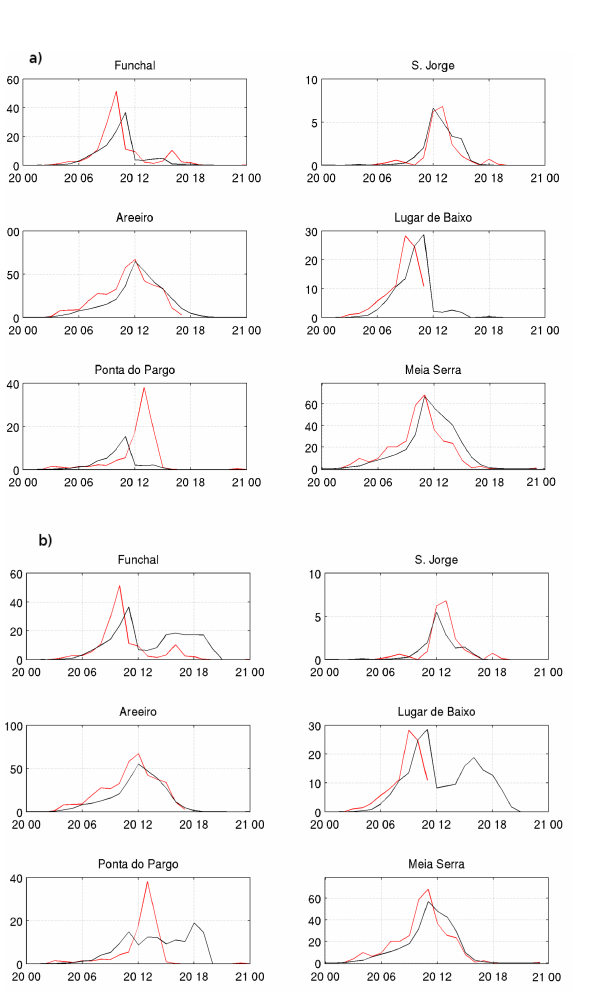
Fig. 16. Measured (red) and simulated (black) hourly precipitation obtained for all stations for ( a ) Run7 and ( b ) Run8, over domain D3. Results show that, in general, the amplitude and phase of precipitation in these runs are well